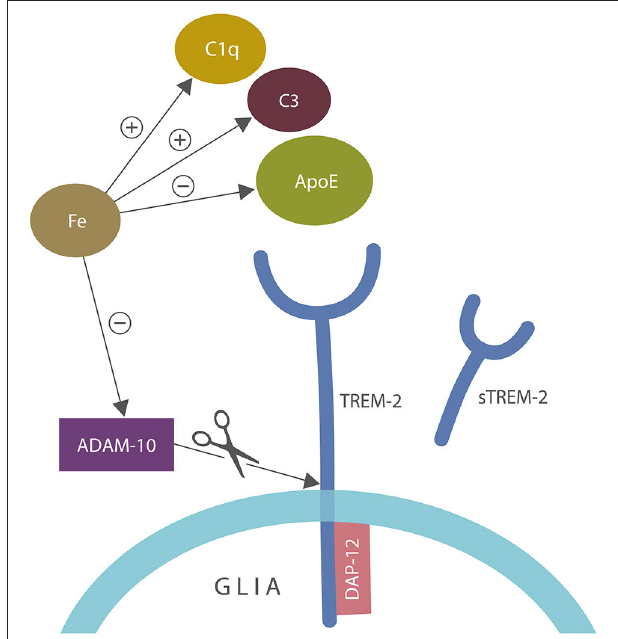
FIGURE 4 | A closer view of microglial ApoE-TREM-2 axis: ApoE, C1q, and C3 engender tolerant phagocytosis (lack of inflammatory response during the clearance of damaged self-components). Iron disrupts this process by promoting prolonged inflammation that overrides immune tolerization. In addition, iron impairs tolerization by altering C1q and ApoE along with C3 upregulation. Iron also inhibits alpha secretase (ADAM-10) which cleaves tolerant TREM-2 receptor into sTREM-2, likely impairing phagocytosis. DAP-12 is a TREM-2 adapter, anchoring this receptor into the cell membrane. ADAM-10 is the same enzyme that cleaves amyloid precursor protein (APP), preventing the formation of amyloid-beta